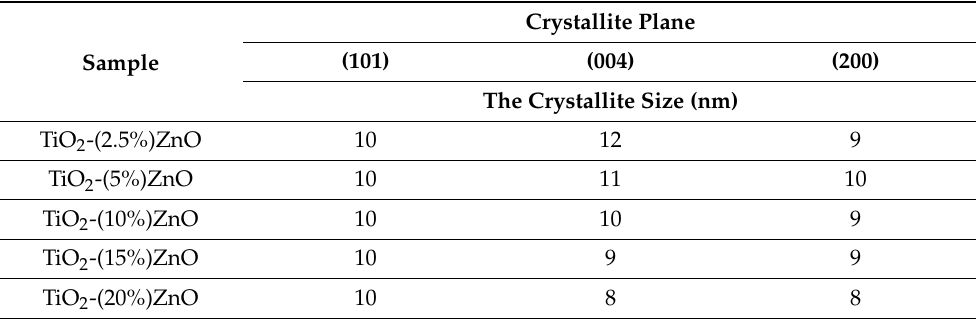
Table 3. The average dimension of crystal domains obtained by Scherrer analysis of the 100, 004, and 200 XRD